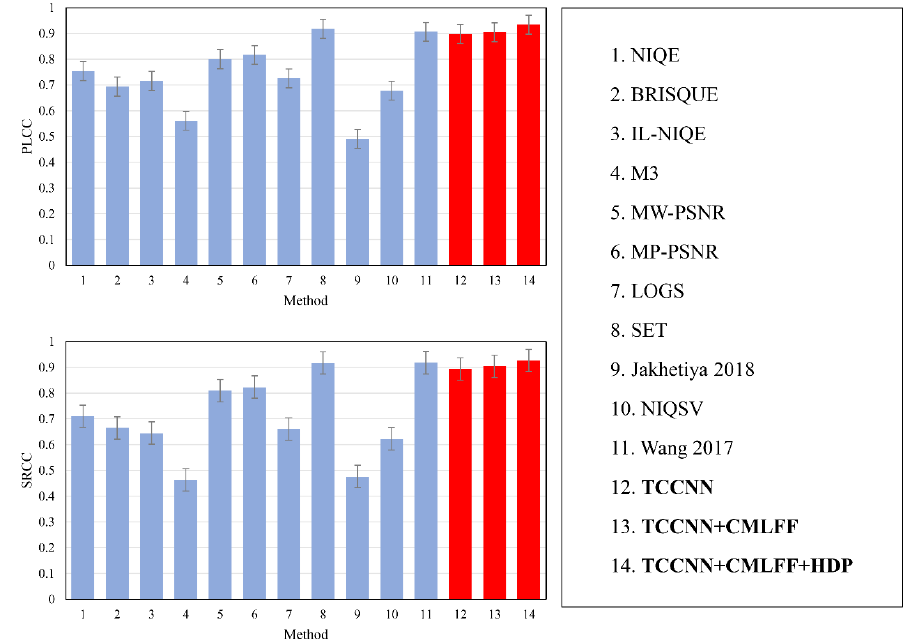
Figure 9. Performance and standard error bars of different methods on the MCL-3D database